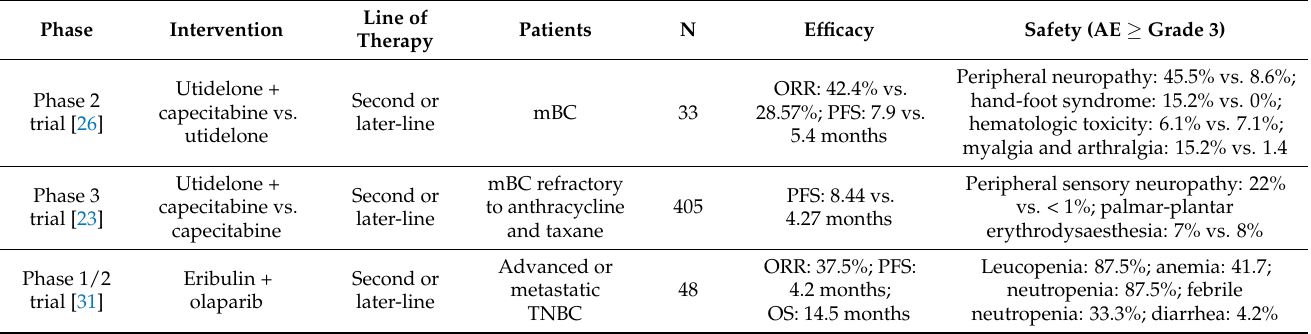
Table 1. Clinical trials of novel chemotherapeutics approved for